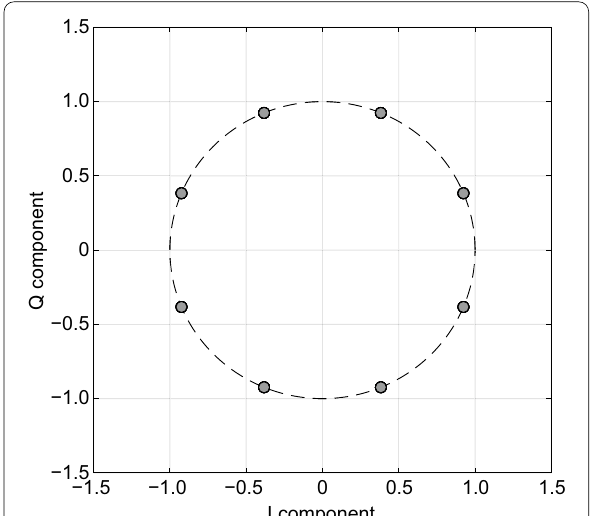
Fig. 8 Constellation of improved Type-III ACE-BOC multiplexing modulation